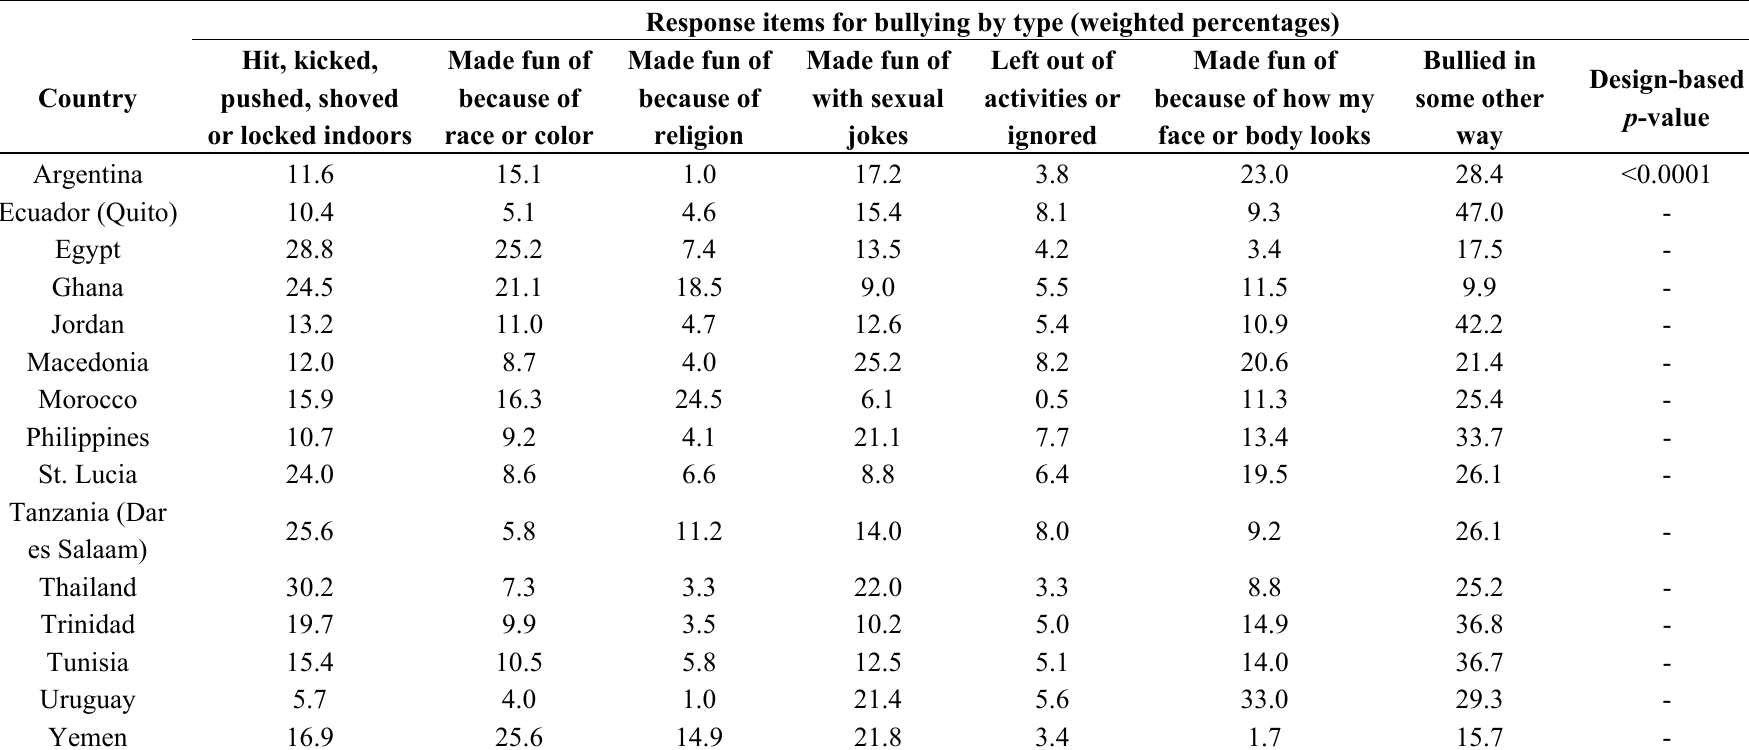
Table 2. Country values by bullied category among a sample of adolescents in low- and middle-income countries (2006–2007). Response items for bullying by type (weighted percentages) Hit, kicked, Made fun of Made fun of Made fun of Left out of Made fun of Country pushed, shoved because of because of with sexual activities or because of how my or locked indoors race or color religion jokes ignored face or body looks